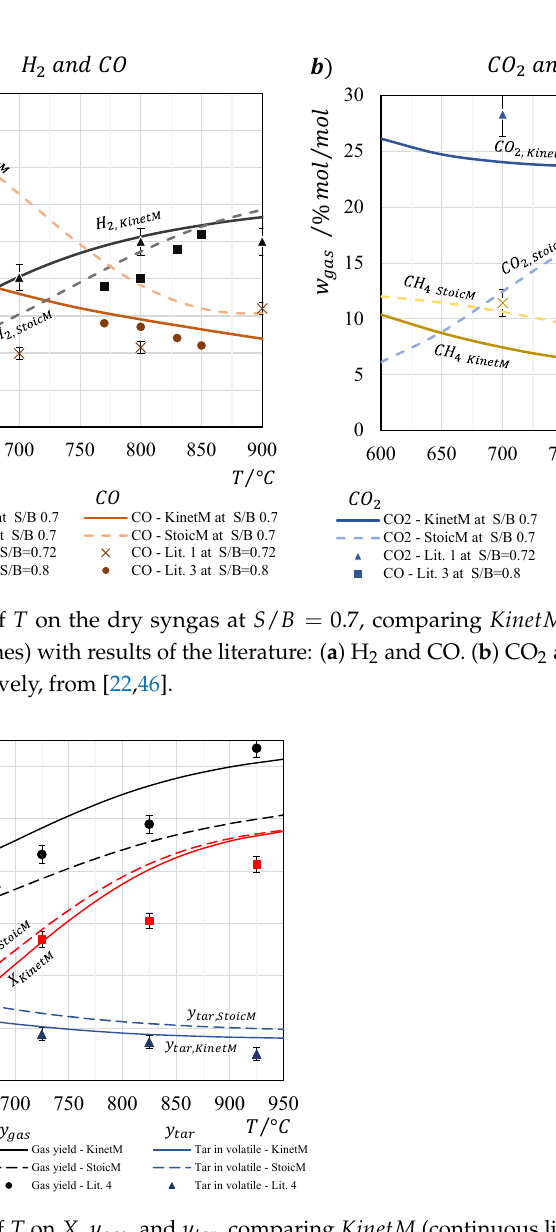
Figure 5. Effects of T on X , y gas , and y tar , comparing KinetM (continuous lines) and StoicM (dashed lines) with results of the literature. Lit. 4 is taken from